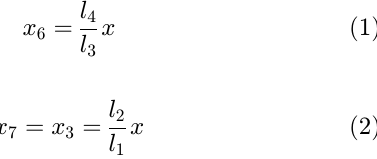
Fig. 2. The same direction